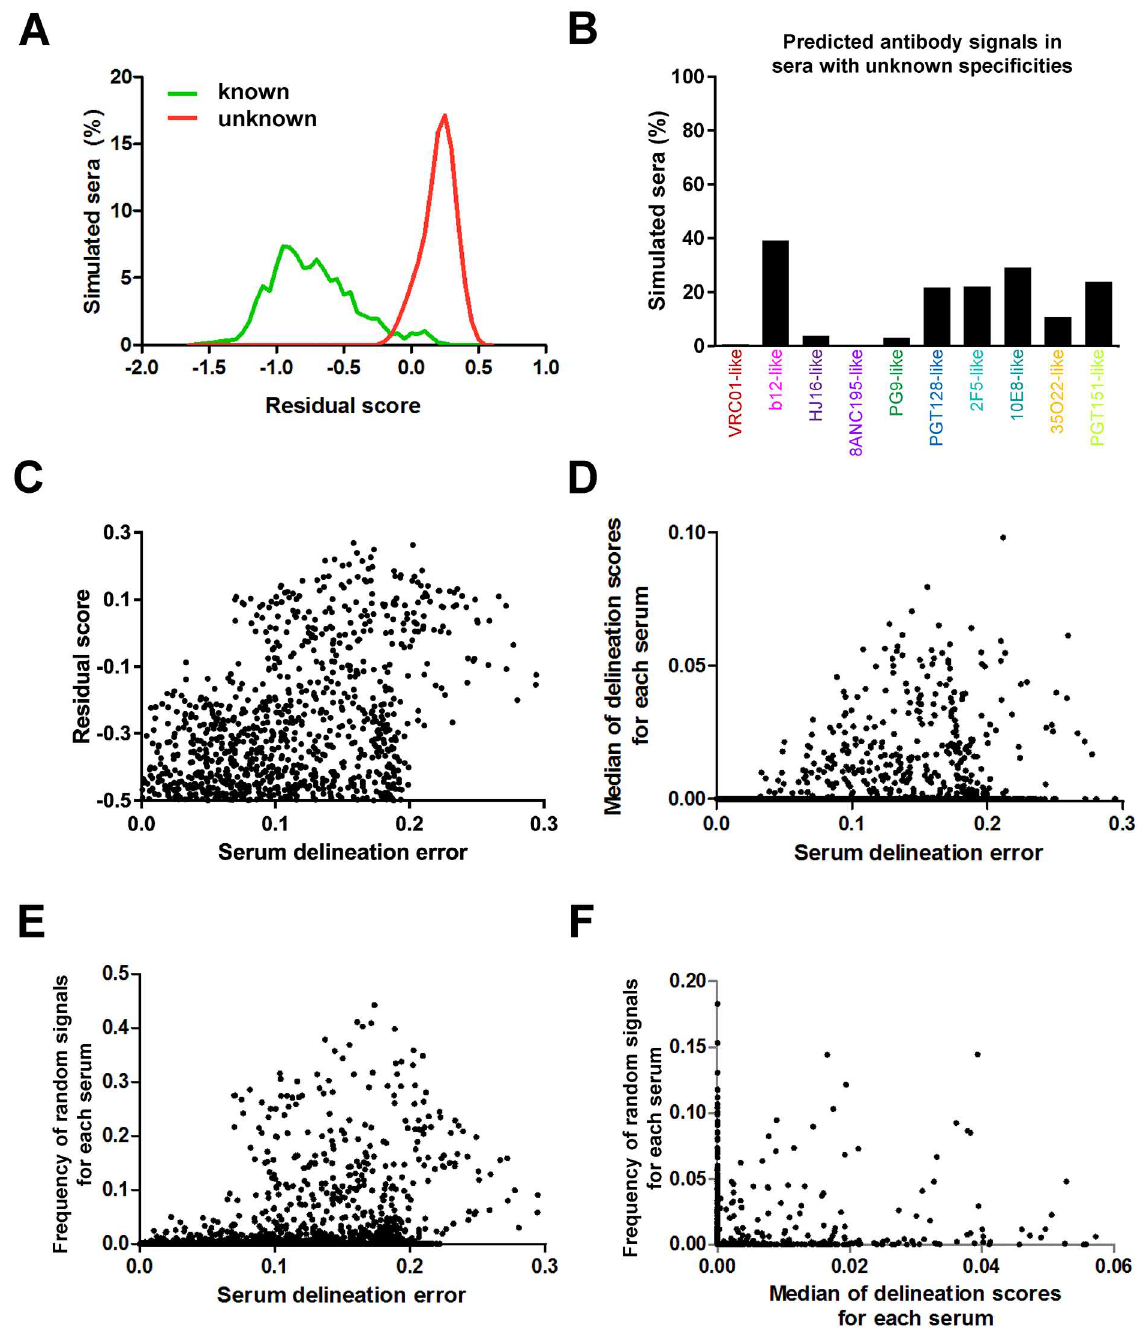
Fig 5. Prediction of potentially novel specificities and confidence scores in NFP analysis with virus panel f61. (A) Histograms of residualscores for simulatedsera with dominant known (green)vs. unknown (red) specificities. (B) Frequency of predicted known antibody signals(colored)for simulatedsera with unknownspecificities. (C-E) Relationship betweenserum delineationerror (a measureof NFP prediction accuracy) and three confidencescores: (C) residualscores (for values of at least -0.5), (D) medianof the ten delineation scores, and (E) frequency of randomsignalsfor a set of simulatedsera with dominant known antibody specificities(dots). For each of the three confidencescores, highervalues were generallyassociated with greater serum delineationerrors. (F) Complementarity of confidencescores. Shown are the frequency of randomsignalsand median of delineationscores for simulatedsera (dots) with residual scores less than -0.1.